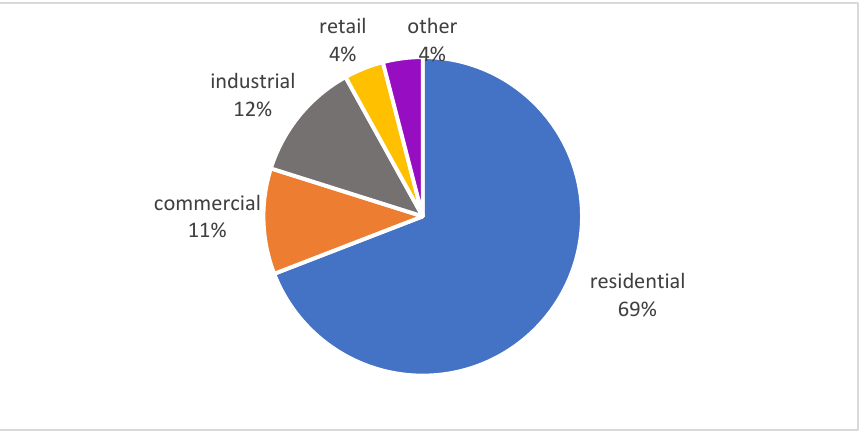
Figure 2. Distribution of coworking spaces related to the type of land use for non-peripheral areas.